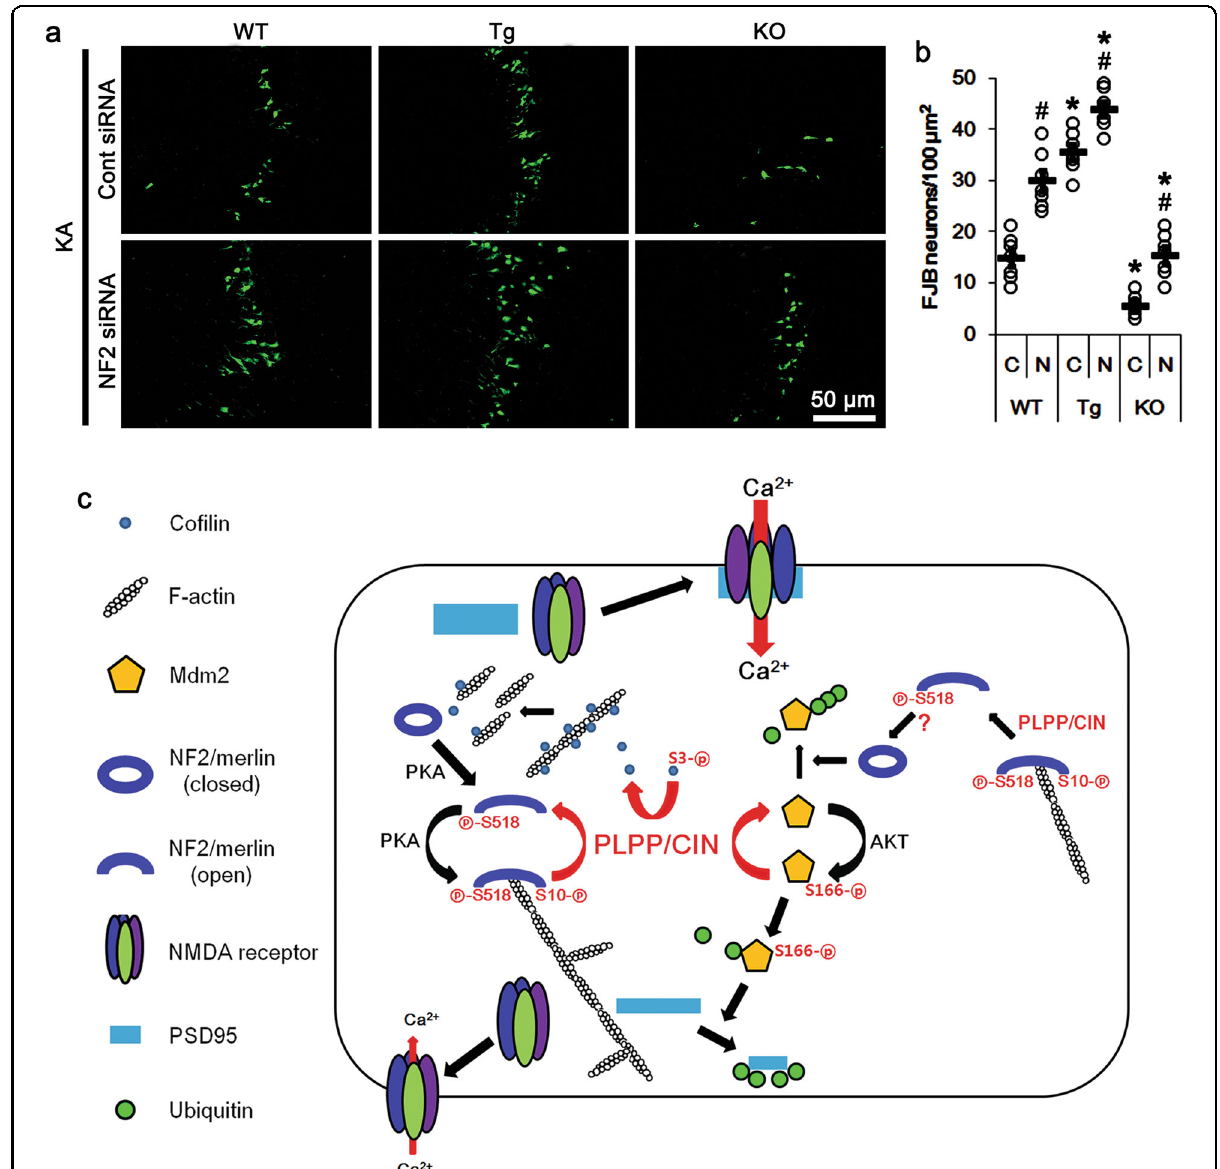
Fig. 8 Effects of NF2 knockdown on CA3 neuronal death in WT, PLPP/CIN Tg , and PLPP/CIN -/ mice following KA injection and the role of PLPP/CIN in NF2-S10 and Mdm2-S166 dephosphorylation. a Representative photos of FJB-positive degenerating neurons in the CA1 region. b Quanti fi cation of the number of FJB-positive neurons in response to KA. Open circles indicate each individual value. Horizontal bars indicate mean value (* ,# p < 0.05 vs. WT and control siRNA-treated animals; n = 7, respectively). c Scheme of the role of PLPP/CIN in NF2-S10 and Mdm2-S166 dephosphorylation. PLPP/CIN-mediated NF2 dephosphorylation decreases F-actin stability and increases NMDAR-PSD95 co-assembly by eliminating the local F-actin barrier. PLPP/CIN also inhibits Mdm2 activity as an E3 ubiquitin ligase for PSD95 by enhancing its S166 dephosphorylation and NF2- mediated Mdm2